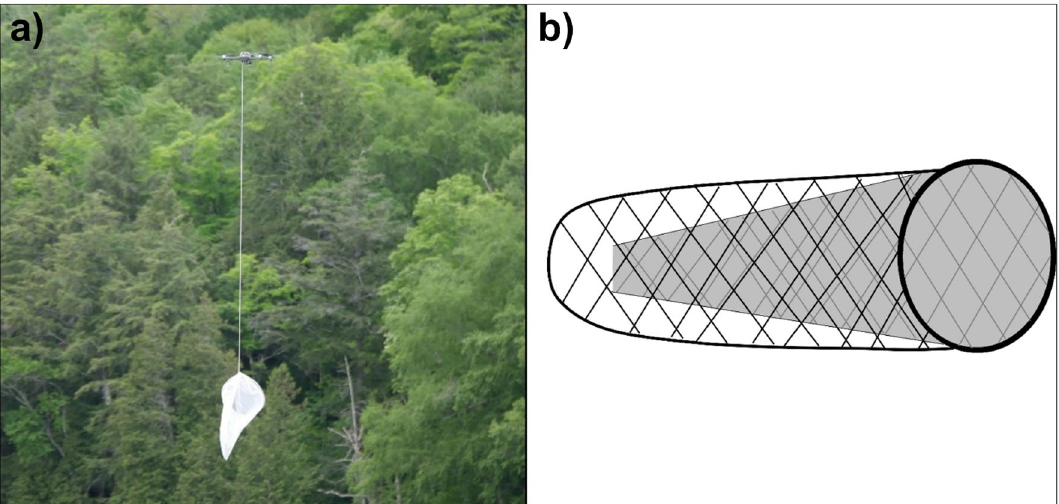
Figure 1. ( a ) Mavic 2 drone with net attached ( b ) illustration of our net design; solid grey represents the second conical layer of tulle